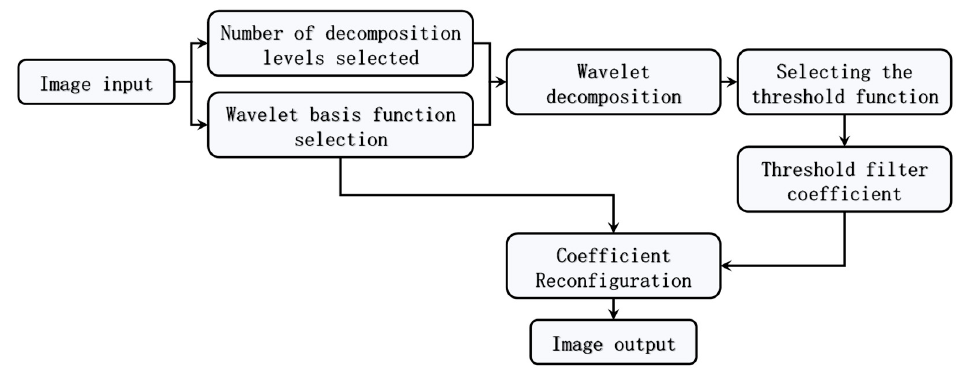
Figure 1. General process of wavelet transform denoising.